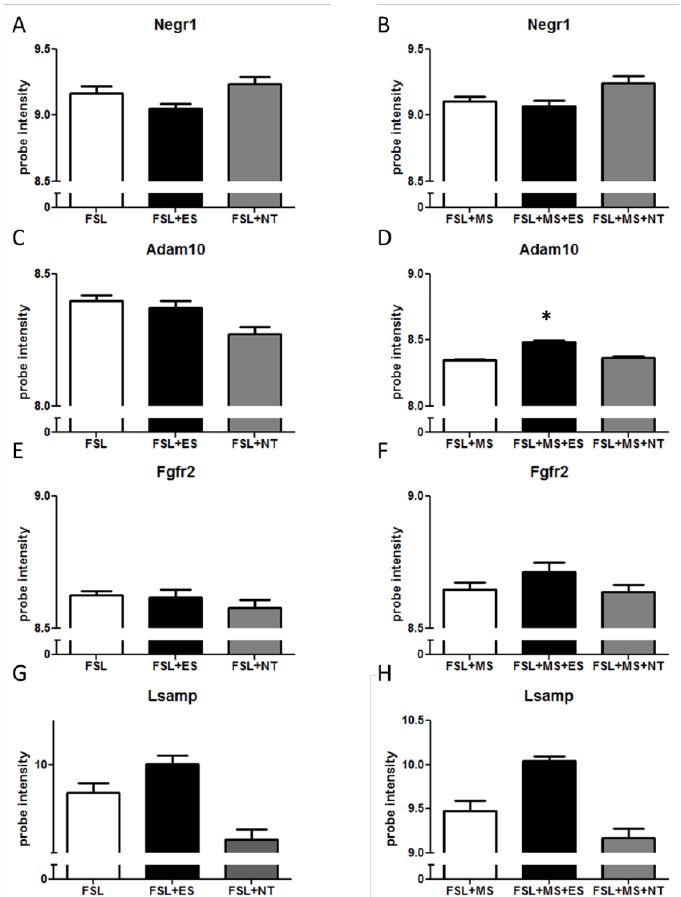
Figure 2. mRNA levels of genes belonging to the Negr1-Fgfr2 pathway in the hippocampus after ES or NT or vehicle administration. FSL rats were either left undisturbed in their home cage (n-MS, A , C , E , G ) or exposed to MS ( B , D , F , H ) as described in the Methods section. ( A , B ) Negr1 expression; ( C , D ) Adam10 expression; ( E , F ) Fgfr2 expression; and ( G , H ) Lsamp expression. * p < 0.05 in the planned comparison vs. vehicle; n = 8 – 10.